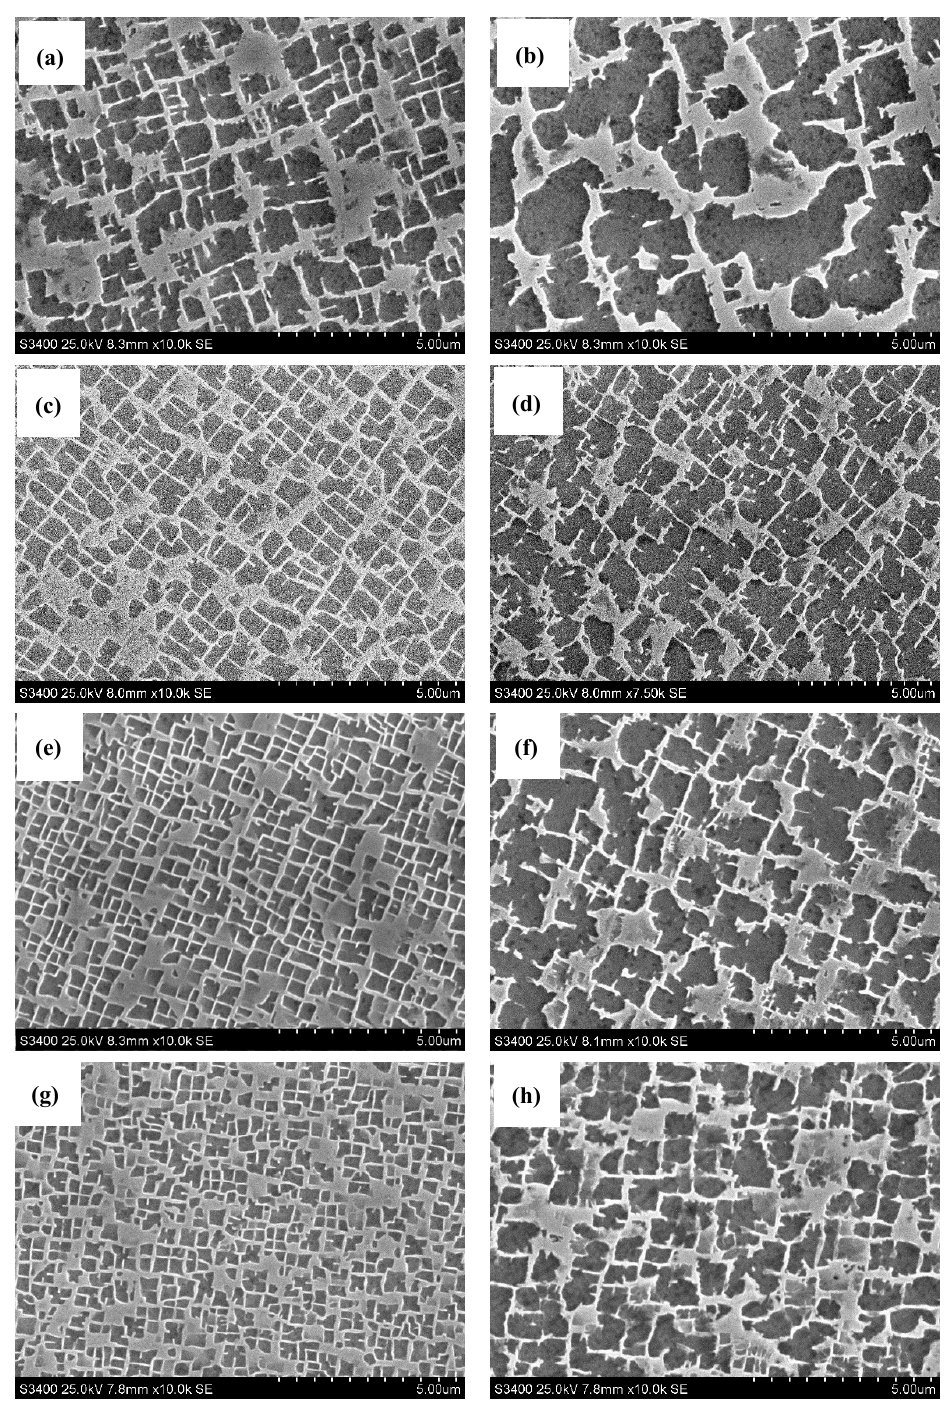
Figure 3. Morphology of γ ’ precipitates in the matrix of γ phase in CMSX-4 superalloy solidified at different withdrawal rates: ( a ) 1, ( c ) 3, ( e ) 5 and ( g ) 7 mm/min—dendritic region, ( b ) 1, ( d ) 3, ( f ) 5 and ( h ) 7 mm/min—interdendritic region .